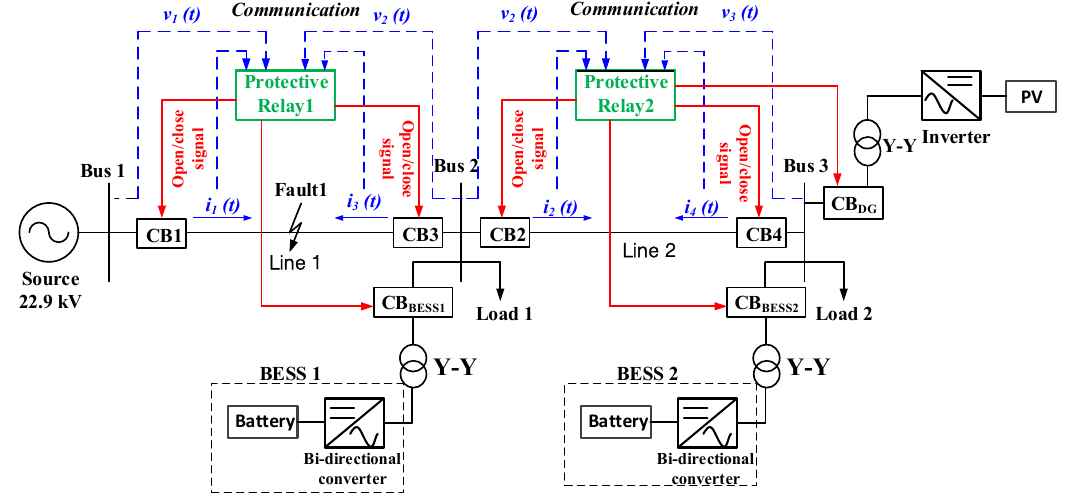
Figure 4. System configuration for establishing the proposed reclosing method.